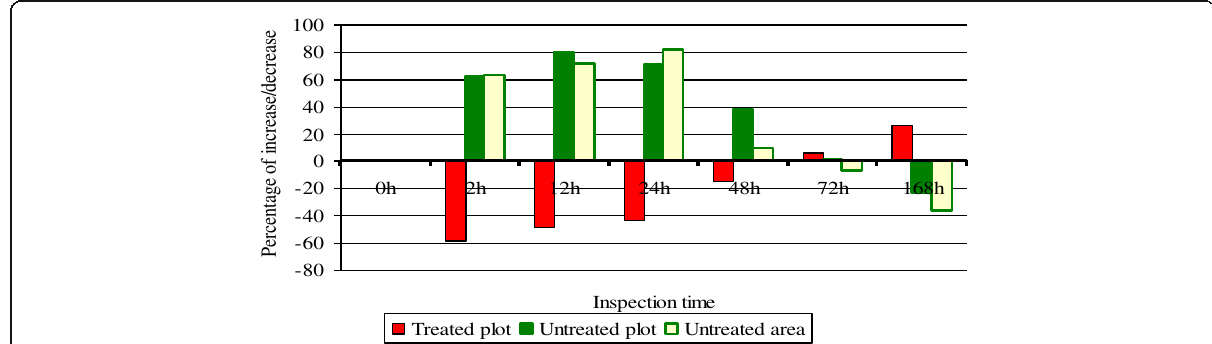
Fig. 1 Percentage of density fluctuations of Coccinella undecimpunctata adults in untreated and sulfur-treated marrow